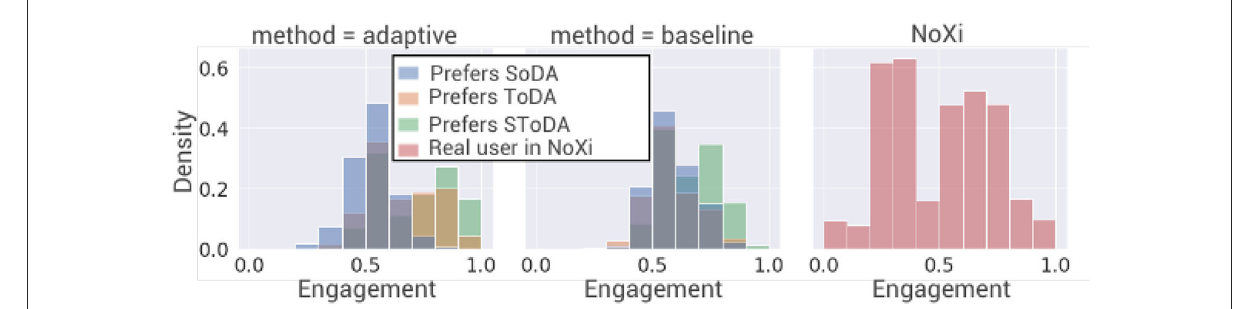
FIGURE5 Density of the level of engagement of the simulated user distribution during 1,000 interactions. SoDA, socially-oriented dialog act; ToDA, task-oriented dialog act; SToDA, socially- and task-oriented dialog act.